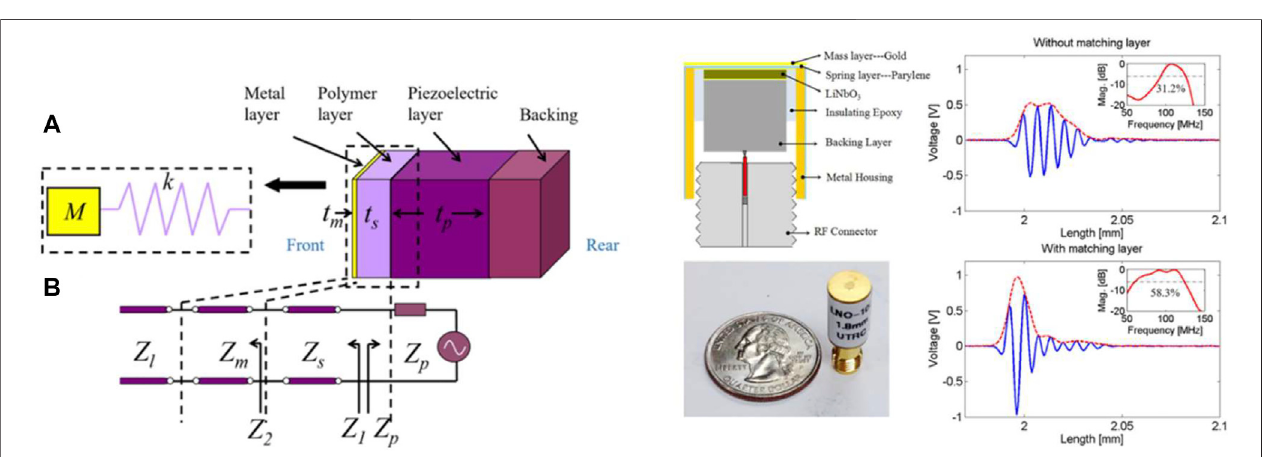
FIGURE 11 | Schematic diagram of the metal polymer matching layer based on mass-spring and its practical application in the transducer.